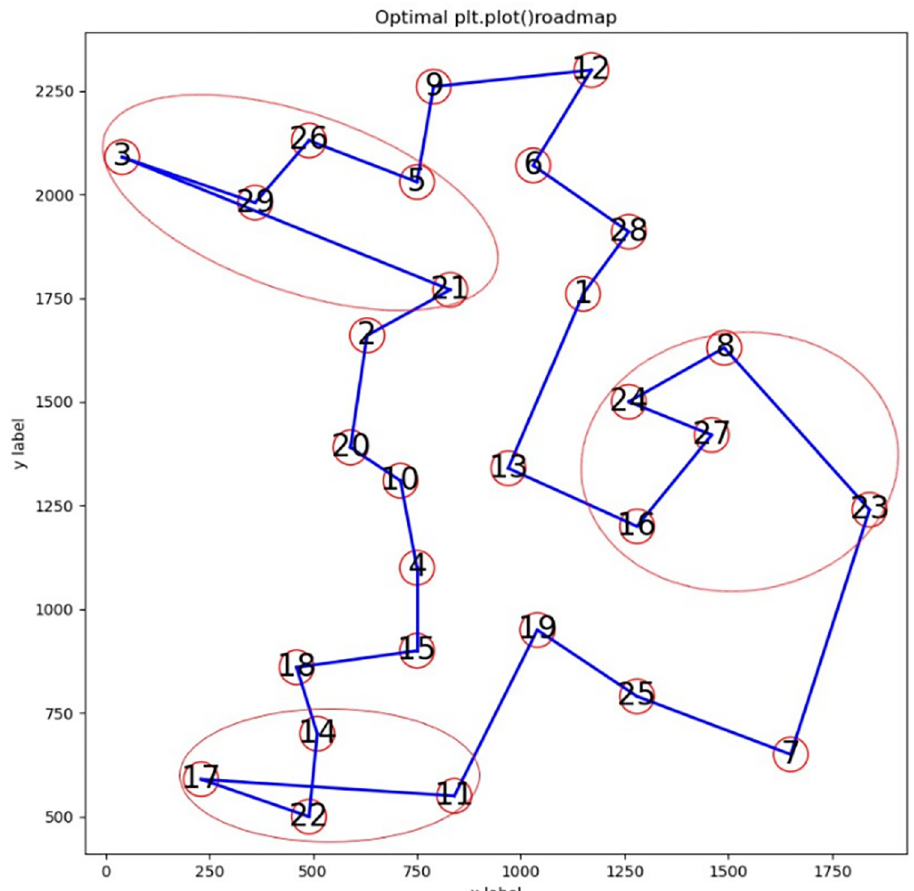
Fig 1. Route for bays29 output by ABSQL